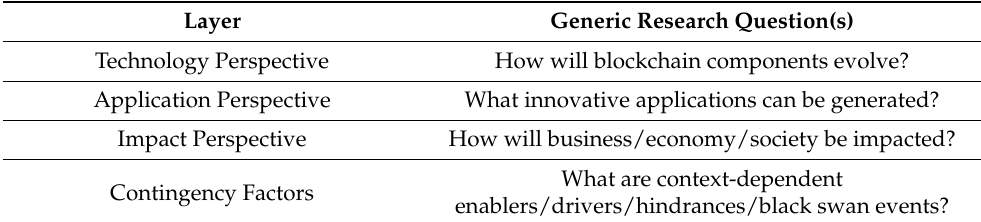
Table 1. Generic blockchain research